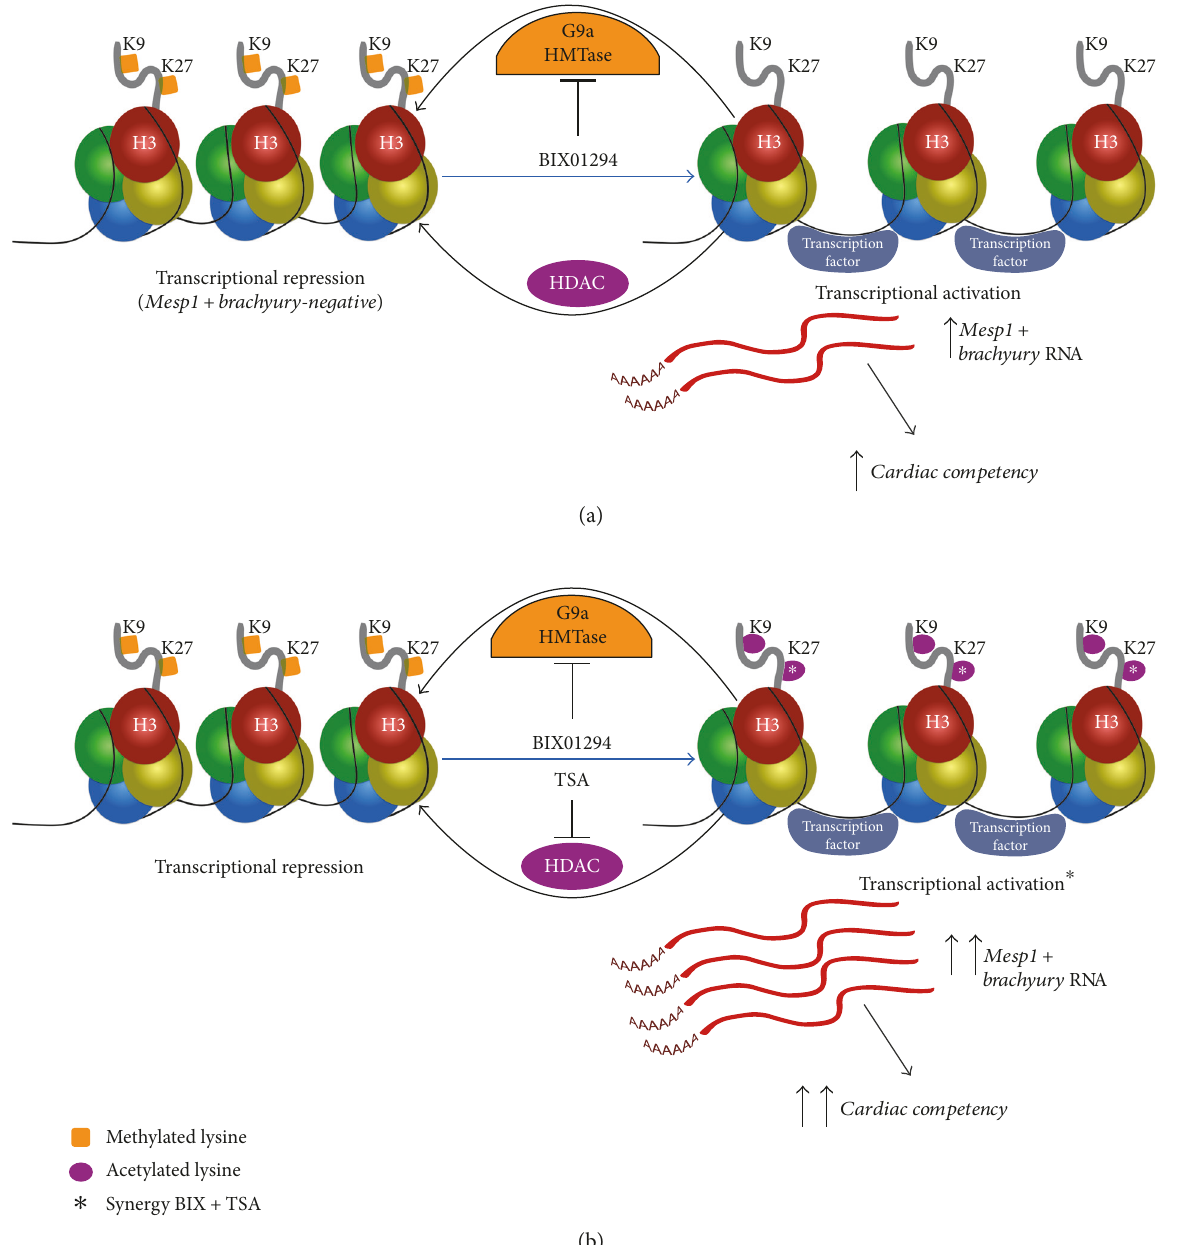
Figure 9: Model for BIX01294 and TSA mediated induction of MSC cardiocompetency. (a) G9a HMTase and HDAC activity in MSCs maintains precardiac genes in a closed chromatin con fi guration and thus are transcriptionally silent. BIX01294 treatment inhibits G9a HMTase methylation of histone H3 lysine residues H3K9 and H3K27 within genes associated with precardiac progenitors, such as Mesp1 and brachyury, thus allowing these genes to be expressed and conferring MSCs with a precardiac cell potential. (b) While inhibition of HDACs by TSA is not su ffi cient to promote Mesp1 or brachyury expression from bone marrow MSCs, this drug acts synergistically (asterisk) with BIX01294 in the transcriptional activation of precardiac gene expression and acquisition of a cardiac competent cell phenotype. We hypothesize that this enhanced precardiac gene expression and cardiocompetency supported by the coaddition of these two drugs is due to their cooperative enhancement of H3K27 acetylation (asterisks), which is a known epigenetic indicator of cardiac gene expression in the early